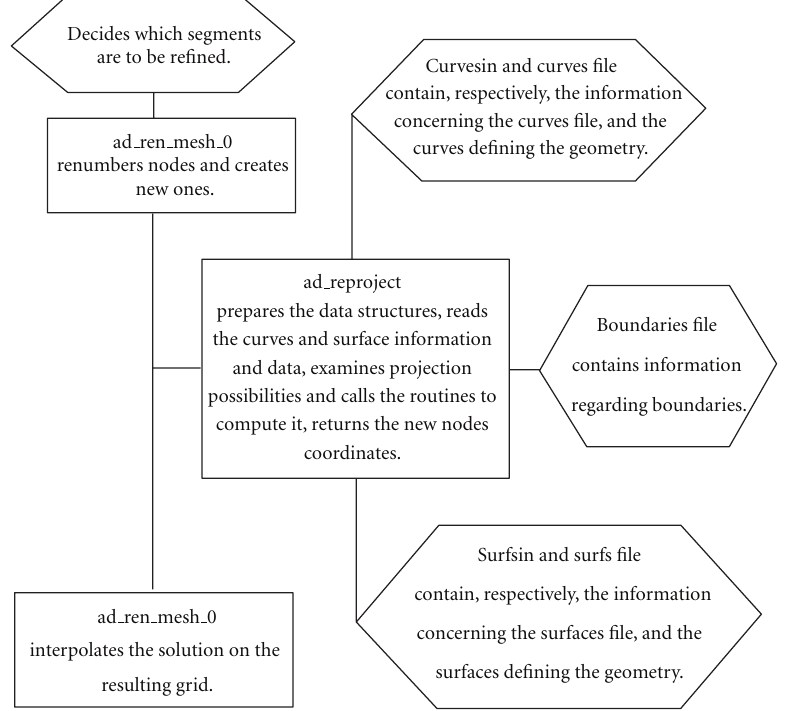
Figure 3: Brief schematic of the reprojection algorithm